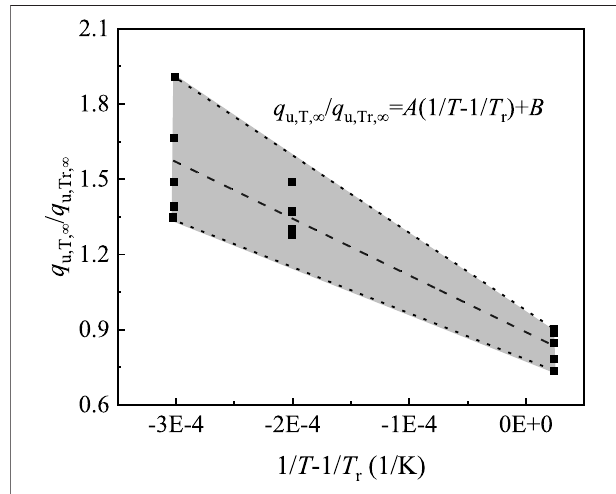
Frontiers in Materials |